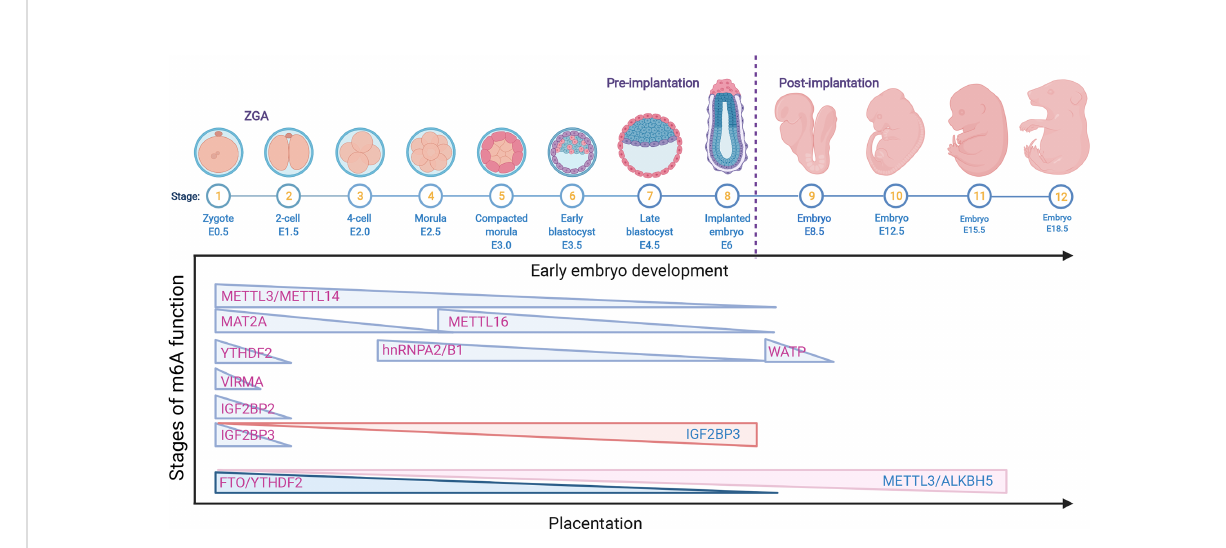
FIGURE 2 The role of m6A RNA modi fi cations in early embryo development and placentation. The downregulation of the m6A RNA modi fi cations METTL3, METTL14, METTL16, MAT2A, VIRMA, WATP, YTHDF2, hnRNPA2/B1 and IGF2BP2/3 is related to early embryo development; however, the upregulation of IGF2BP3 also causes a delay in late development. In addition, the decrease in FTO and YTHDF2 is associated with early placental dysfunction, while the overexpression of METTL3/ALKBH5 is related to late abnormal